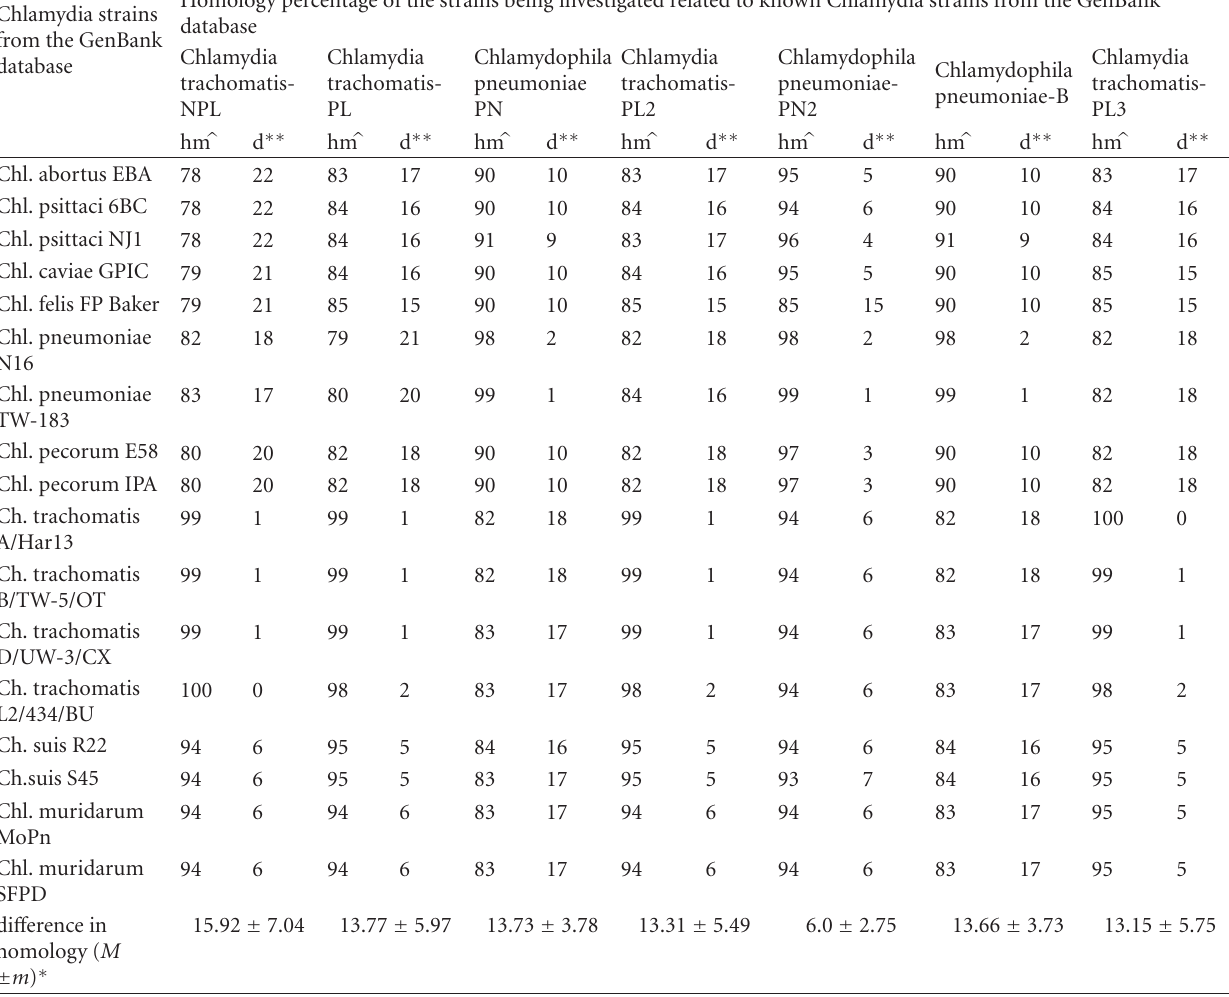
Table 1: Comparative analysis results concerning homology of the nucleotide sequence 16S–23S of the middle ribosomal cluster and 23S rRNA I gene domain of the Chlamydia strains being investigated with analogous sequences of other